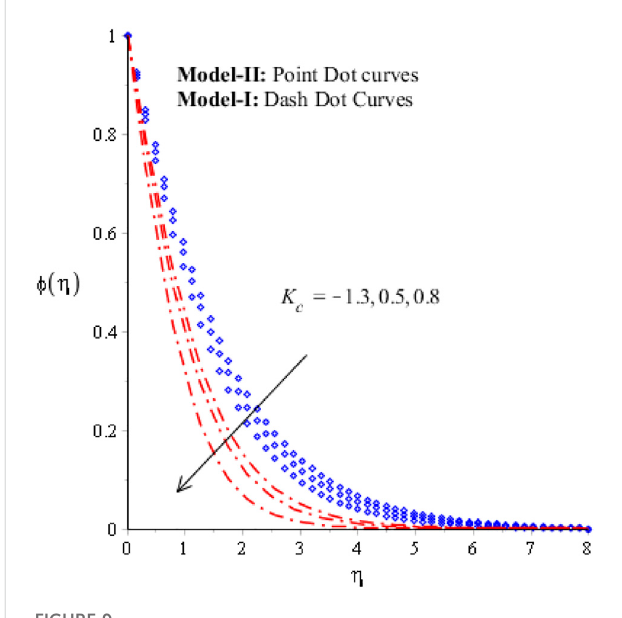
FIGURE 7 Effect of We on temperature curves when α (cid:2) 0 . 4 , n (cid:2) 0 . 3 , Re (cid:2) 3 . 0 , γ (cid:2) 0 . 5 , β (cid:2) 1 . 3 , Λ (cid:2) 0 . 32 , Pr (cid:2) 5 , ϵ (cid:2) 0 . 7 , H t (cid:2) − 1 . 6 , Sc (cid:2) 0 . 4 , λ (cid:2) 0 . 4 , K c (cid:2) − 1 . 7 , χ (cid:2) 0 . 3 , and τ (cid:2) 0 . 3.